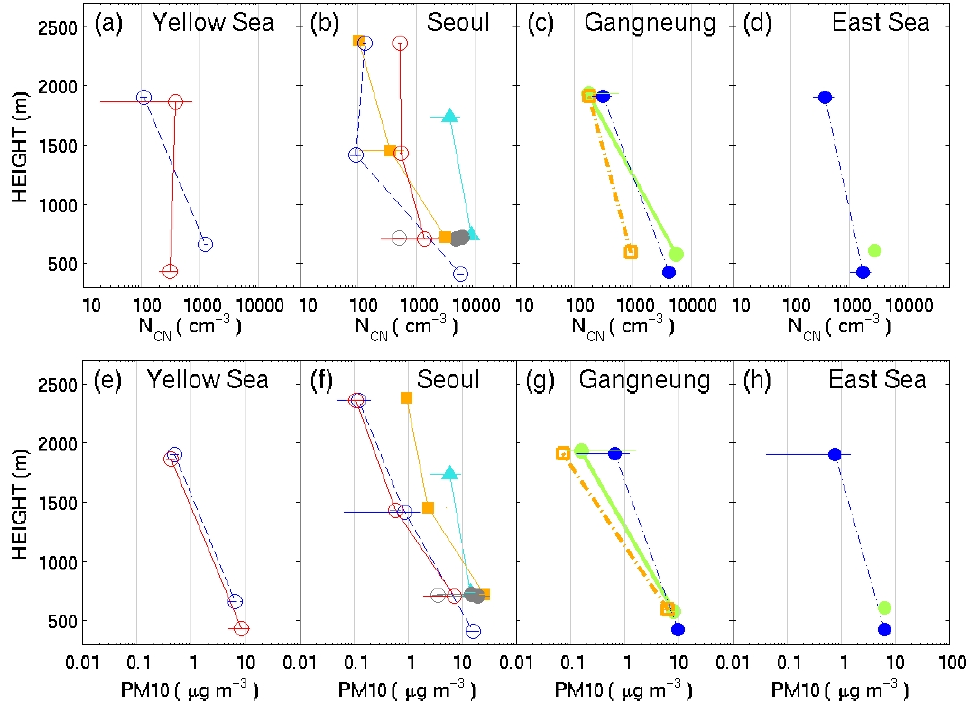
Figure 4. The vertical structure of total number concentration (Ncn, cm − 3 ) and PM10 ( μ g m − 3 ) obtained from the Yellow Sea, Seoul, Gangneung and East Sea. ( a – d ) indicate Ncn and ( e – h ) represent PM10. Individual dots indicate the mean value of Ncn and PM10 obtained at constant heights (level- leg flights). The vertical lines connect aerosols obtained from level-leg flights. The horizontal bar represents standard deviation. Gangneung and East Sea flights were made along the coastline, 10 km apart (Figure 1). The colors are the same as those shown in back trajectories in Figure 2. For example, the blue circles with dashed lines in Figure 4a indicate Ncn obtained on 6 December AM flight.